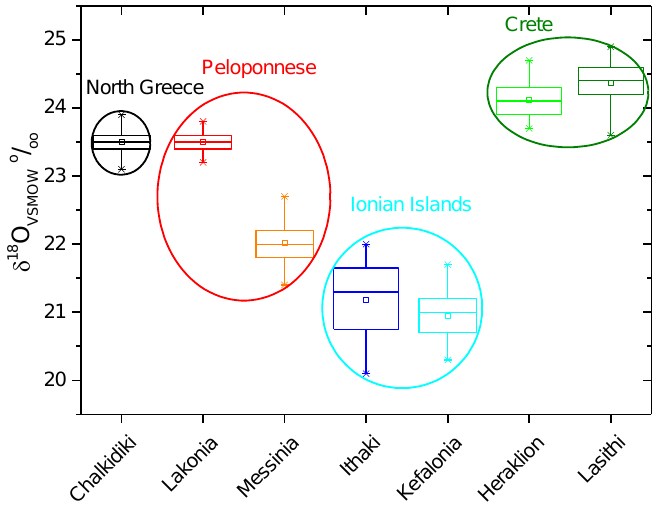
Figure 2. δ 18 O VSMOW of olive oils from Greek areas.